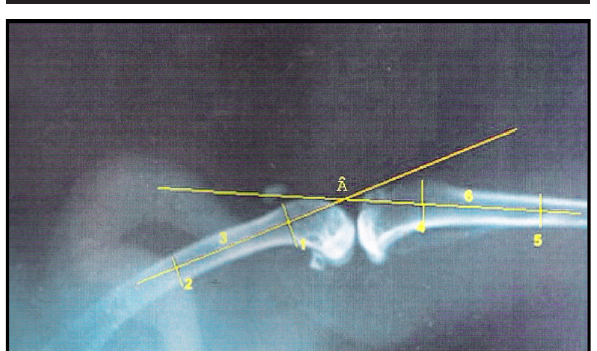
FIGURE 3 - Method of mensuration radiographic of the angle of extension of the knee